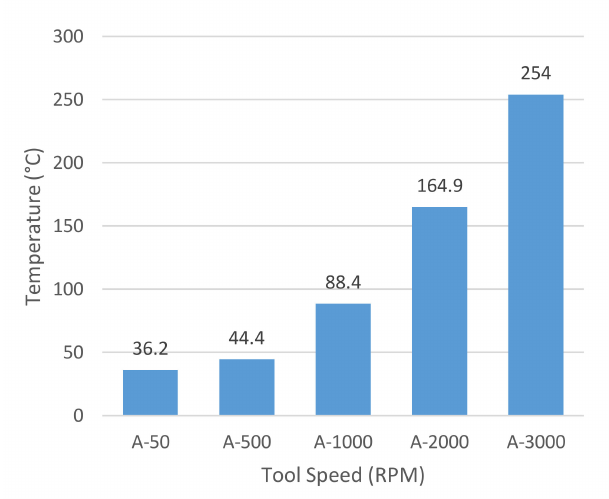
Figure 7. Maximum temperature rises at varying rotational speed, as observed during ISF of annealed AA-2219 sheet.